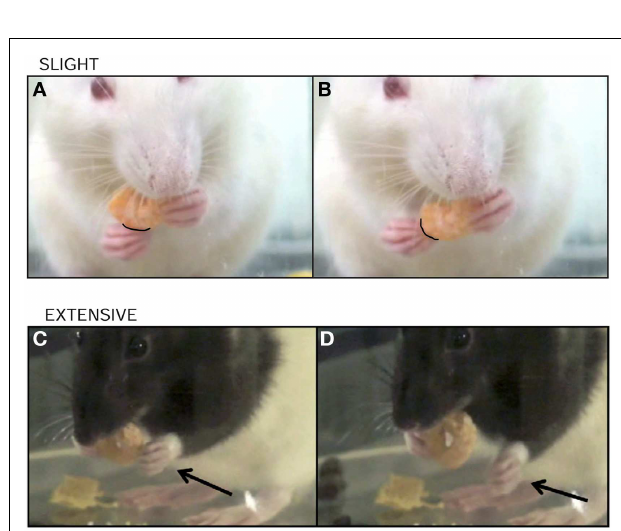
FIGURE 4 |Amendment: predominant elbow position .The rat is assessed for the most common position (more than 50% of the time) assumed by the elbow during eating. Extended is when the elbow is held straight with an